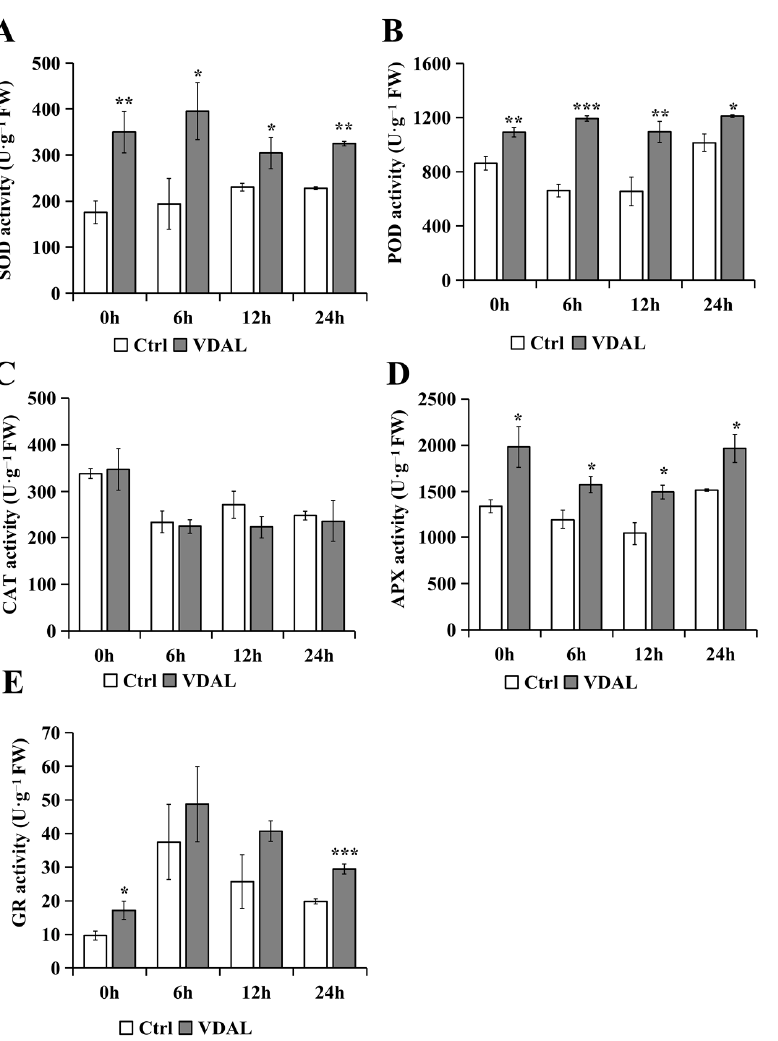
Figure 3. Antioxidant enzyme activities of B. rapa inoculated with S. sclerotiorum after spraying with water or 1 g ∙ L − 1 VDAL. ( A ) SOD activity of B. rapa at 0, 6, 12 and 24 h after inoculation. ( B ) POD activity of B. rapa at 0, 6, 12, and 24 h after inoculation. ( C ) CAT activity of B. rapa at 0, 6, 12, and 24 h after inoculation. ( D ) APX activity of B. rapa at 0, 6, 12, and 24 h after inoculatioI ( E ) GR activity of B. rapa at 0, 6, 12, and 24 h after inoculation. Three independent replicates were performed. Student’s t -test (* p < 0.05; ** p < 0.01; *** p < 0.001) was used to estimate significant